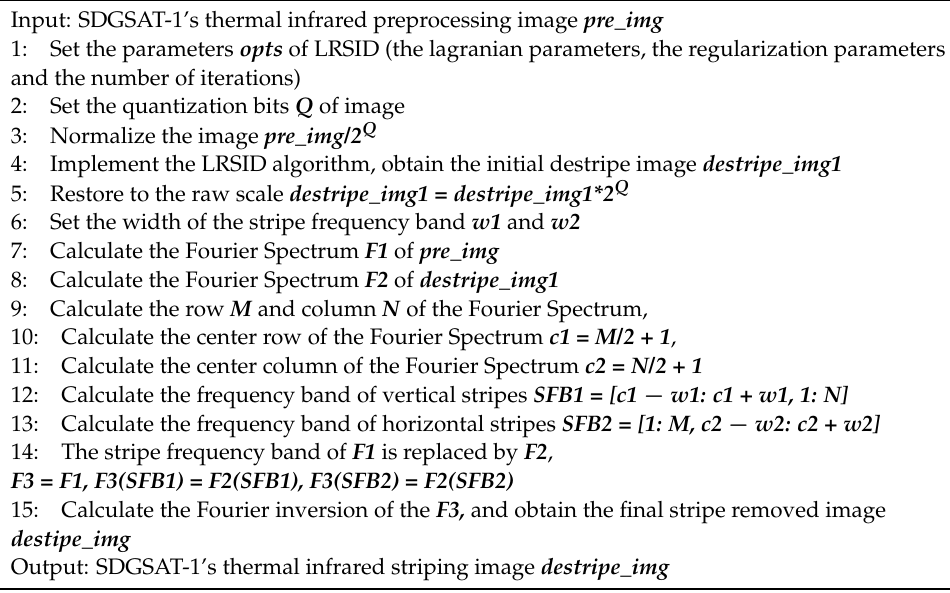
Algorithm 2: Striping algorithm based on LRSID and frequency domain guidance